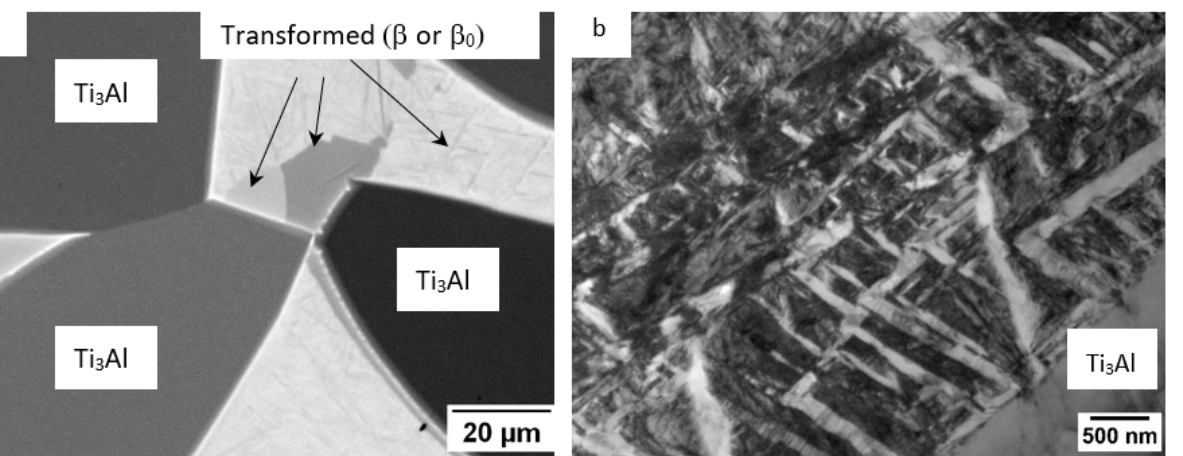
Figure 3. Z4 (Ti-44.7Al-16.5Zr at. %), heat treated at 1000 °C/1000 h; ( a ) TEM bright field, ( b ) diffrac- tion pattern of ZrAl 2 .